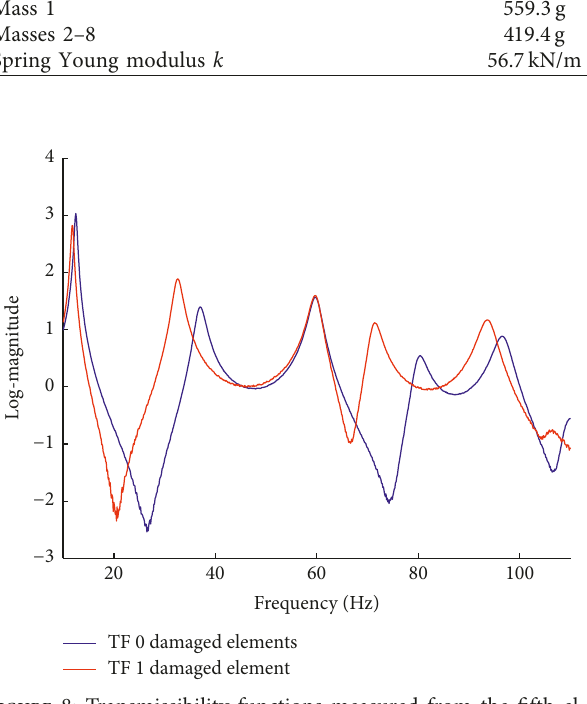
Figure 8: Transmissibility functions measured from the fifth el- ement of the spring series system. Blue line corresponds to the no damage scenario, whereas in orange, the system has one randomly damaged element.